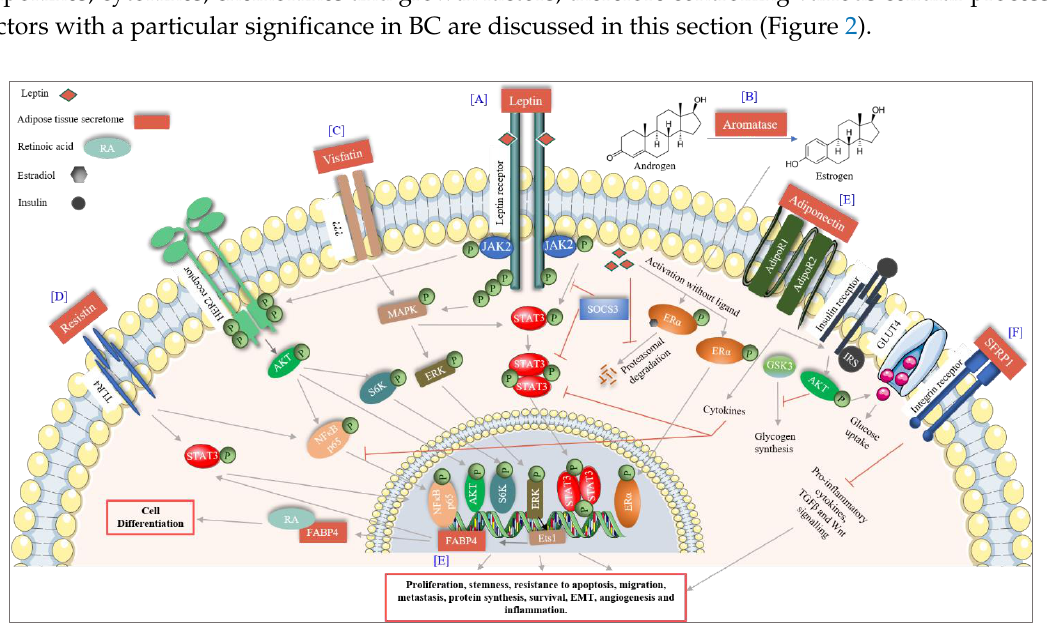
Figure 2. Adipose tissue signaling in breast cancer. ( A ) Leptin, a major adipocytokine released